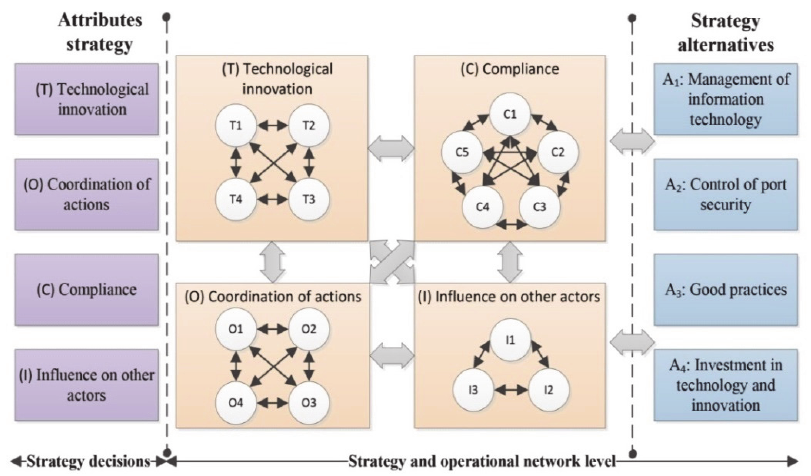
Fig. 4 . The conceptual ANP model for Port